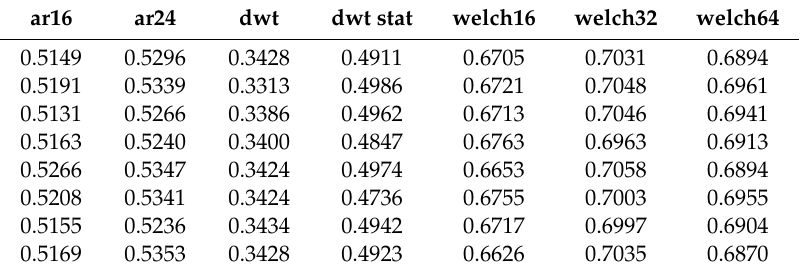
Table 22. Accuracy of test data classification using the neural network with a single hidden layer. The evaluation was repeated 10 times for each parameterization